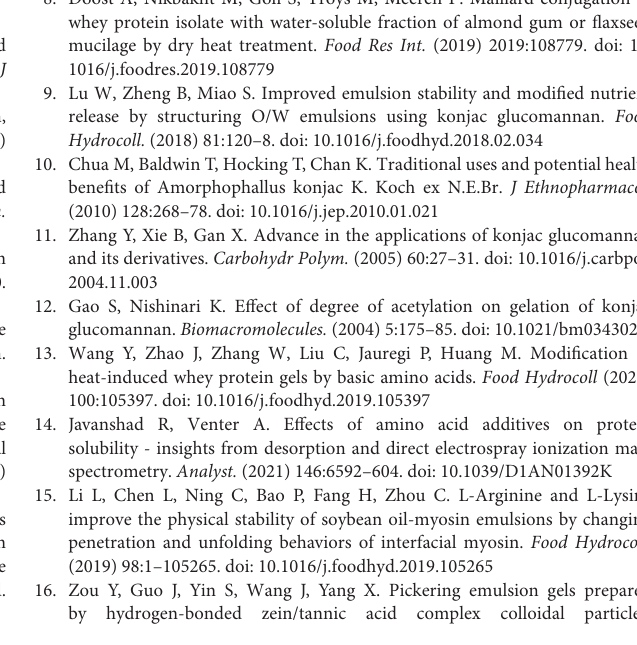
Supplementary Figure 1 | The appearance (A) and centrifugal stability (B) of emulsion with ZCPs, L-Lys, and 0 h reaction time. Supplementary Figure 2 | Contact Angle of emulsion stabilized by